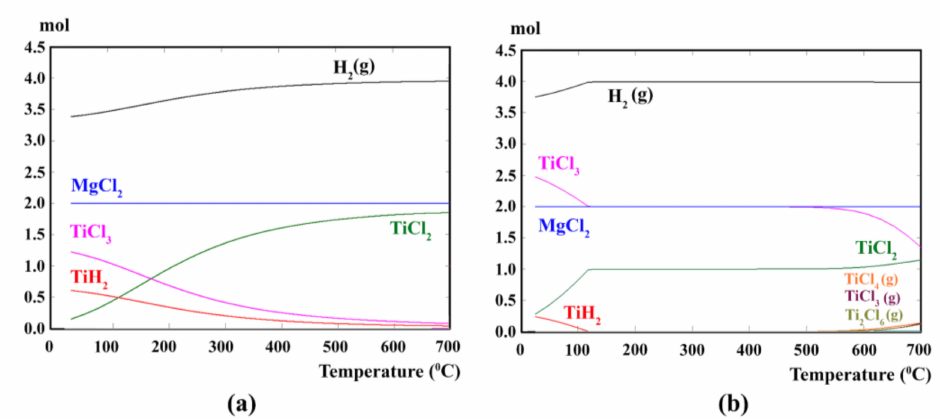
Figure 4. Theoretical equilibrium phase composition calculated for molar ratio of ( a ) TiCl 4 :MgH 2 = 2:2 and ( b ) TiCl 4 :MgH 2 =